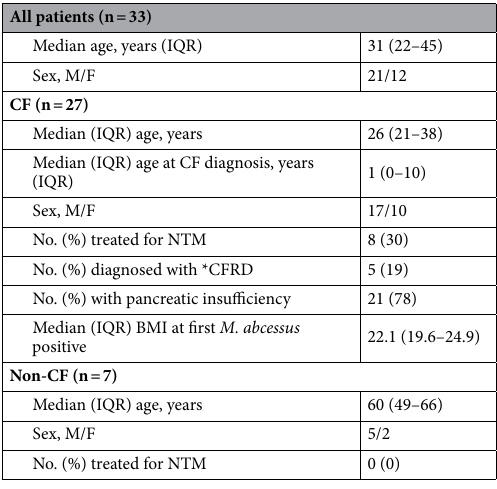
Table 1. Description of patients. * CFRD : cystic fibrosis-related